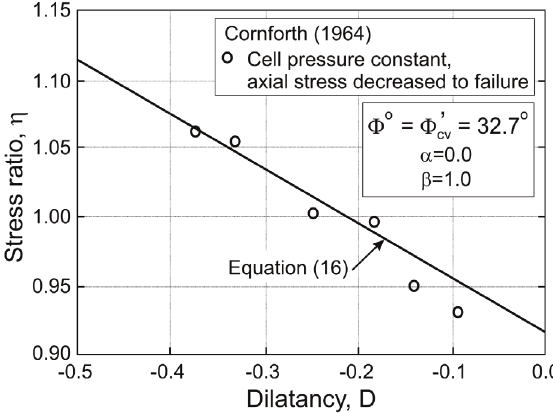
Fig. 14. Stress ratio-dilatancy at failure of Brasted